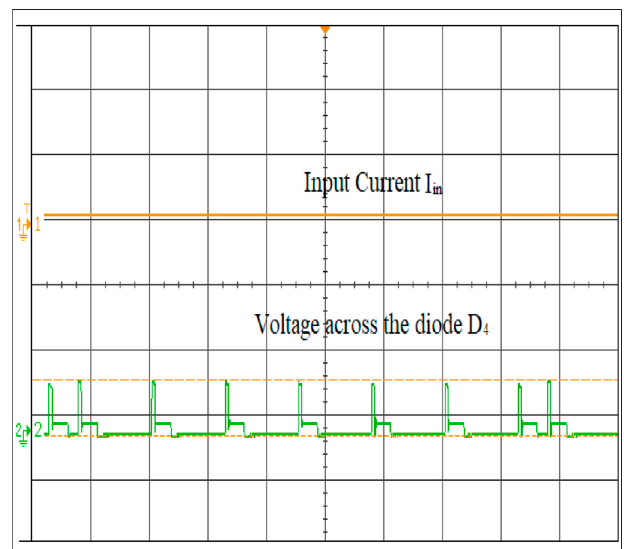
FIGURE 13 | Current through the coil I L2 . The voltage across the diode D 1 Voltage across the diode D 2 .